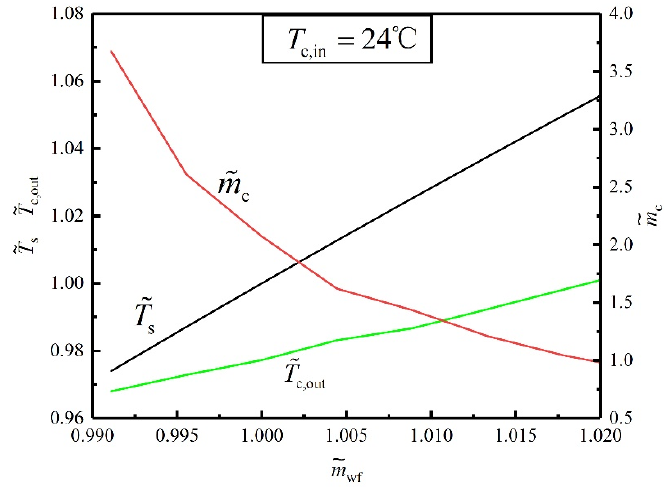
m  . Figure 6. Influences of (cid:101) m wf on the (cid:101) T s , (cid:101) T c , out and (cid:101) m c . T  and T  , m  on the Figure 6. Influences of c , c out s wf Figures 7–10 show the influences of the dimensionless total HTA (cid:101) A c and dimensionless HTR (cid:101) Q c on the (cid:101) W c , m , (cid:101) d c , out , opt , (cid:101) T s , (cid:101) T c , out , and (cid:101) m c , respectively. One can find from the figures that the minimum dimensionless TPP (cid:101) W c , m diminishes with the rise of (cid:101) A c , and the optimum dimensionless tube OD (cid:101) d c , out , opt remains unchanged with the rise of (cid:101) A c , which indicates that increasing HTA is beneficial to reduce the TPP required by the condenser. The